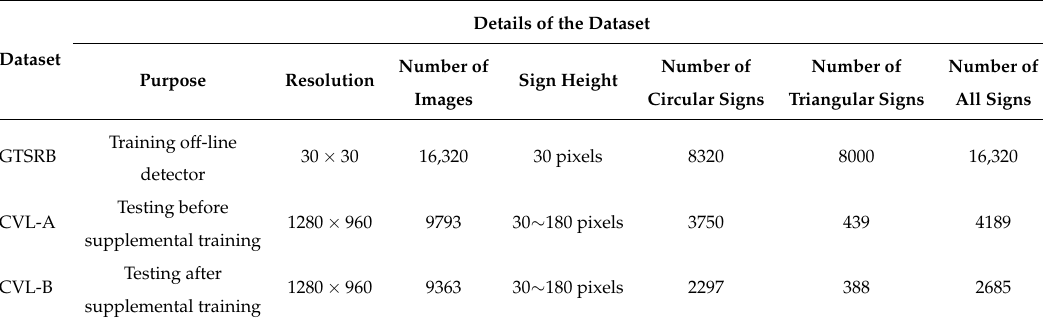
Table 1. Details of the training and testing datasets from GTSRB and